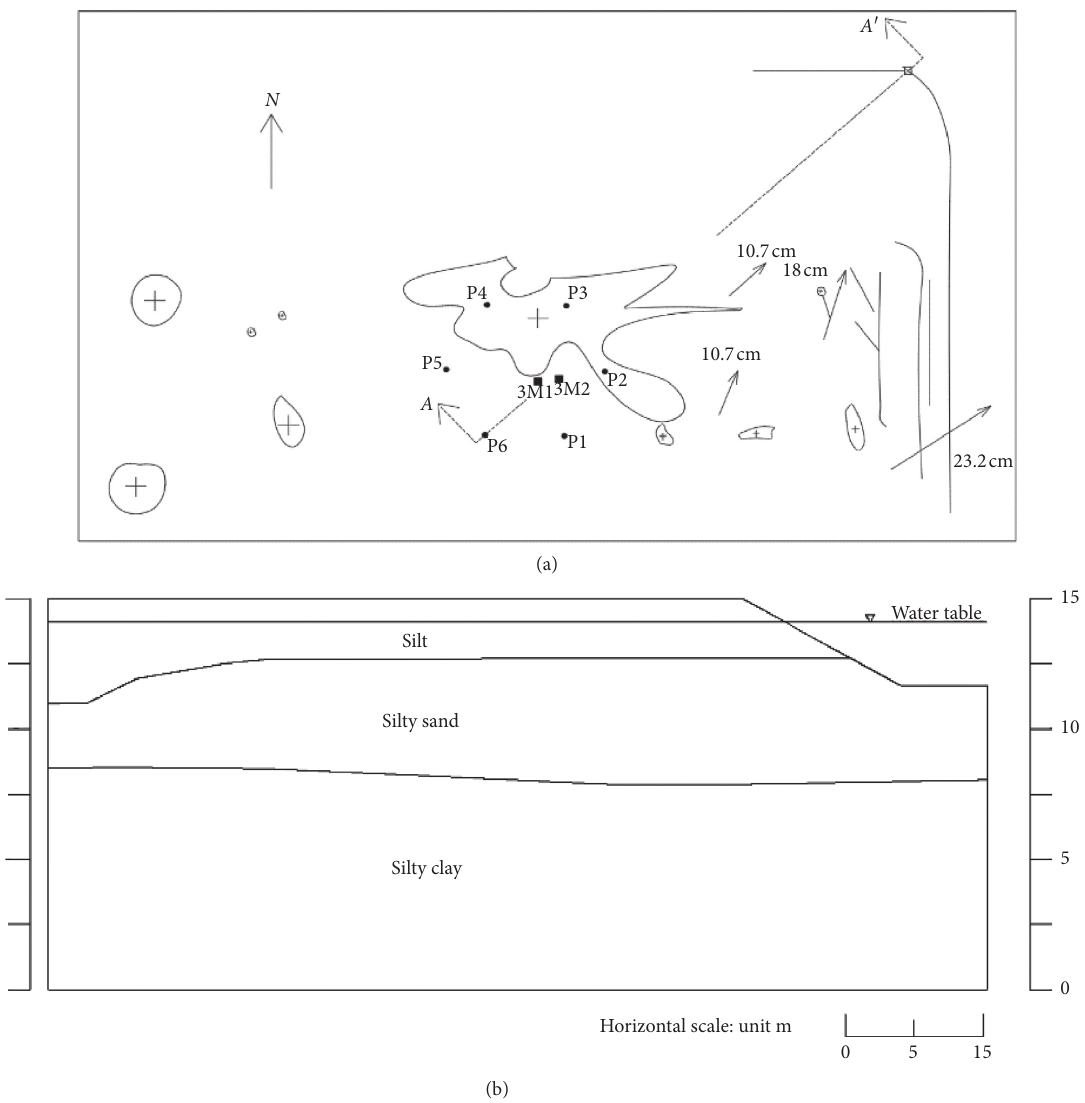
Figure 1: The liquefaction feature and soil profile of Wildlife Site Array. (a) Liquefaction feature of the Wildlife Site Array (after Soroush [24]). (b) The soil profile of Wildlife Site Array (after Makdisi